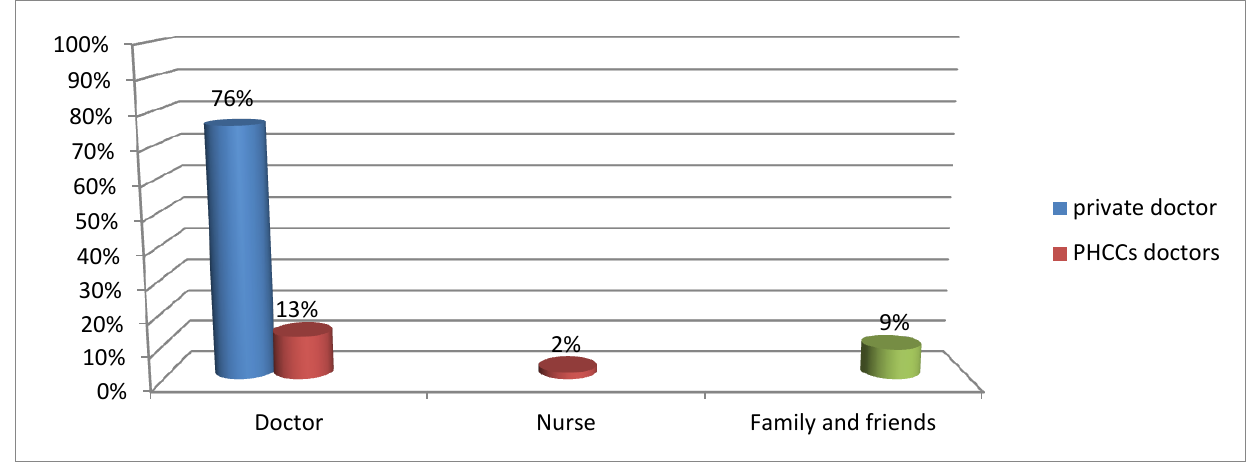
Figure-1-: Source of information Discussion : The sample maternal Socio-